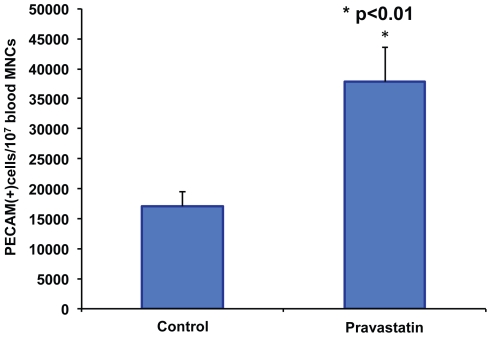
Oral Pravastatin Promotes the Outgrowth of LOEPCs from Blood Mononuclear Cells.Pigs were treated with a placebo or pravastatin (4 mg/kg orally) daily for three consecutive days. Blood mononuclear cells were obtained on day three, and cultured on type I collagen coated dishes to derive LOEPCs. The quantity of LOEPCs per 3×107MNCs plated was determined using flow cytometry to determine the number of PECAM positive cells after 14 days in culture. The data are presented as the means ± SEM from eight different animals. * p<0.01 vs. control using a paired t-test.